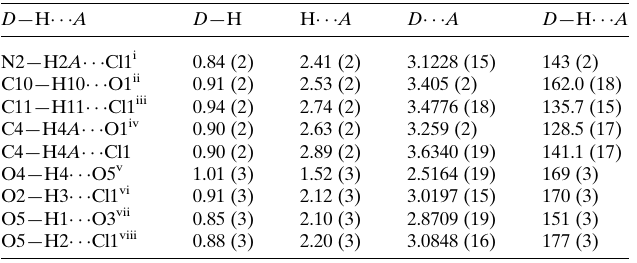
Table 1 Hydrogen-bond geometry (A˚ , (cid:4)